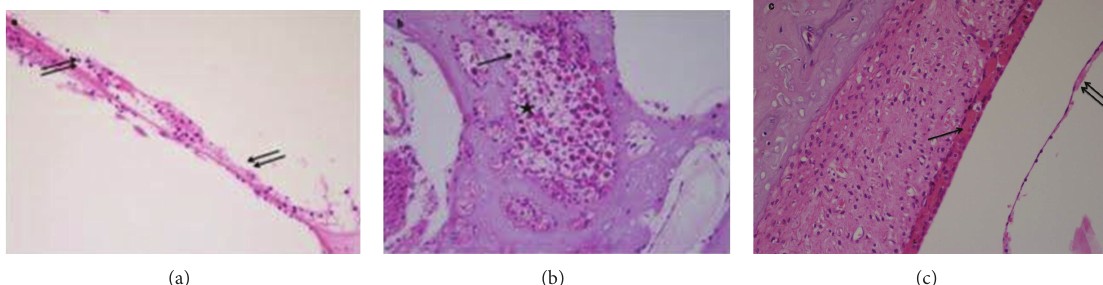
Figure 2: Showing extensive loss of the normal microarchitecture of the organ of Corti, severe destruction of the outer hair cells ( ↑↑ ). (b) Showingdecreasednumberofspiralganglionneuronswithcellchanges(star),suchasvacuolationofthecytoplasm( ↑ ).(c)Showingshrinkage of the intermediate cells ( ↑ ), edema of stria, and swelling of the epithelial cells of Reissner’s membrane ( ↑↑